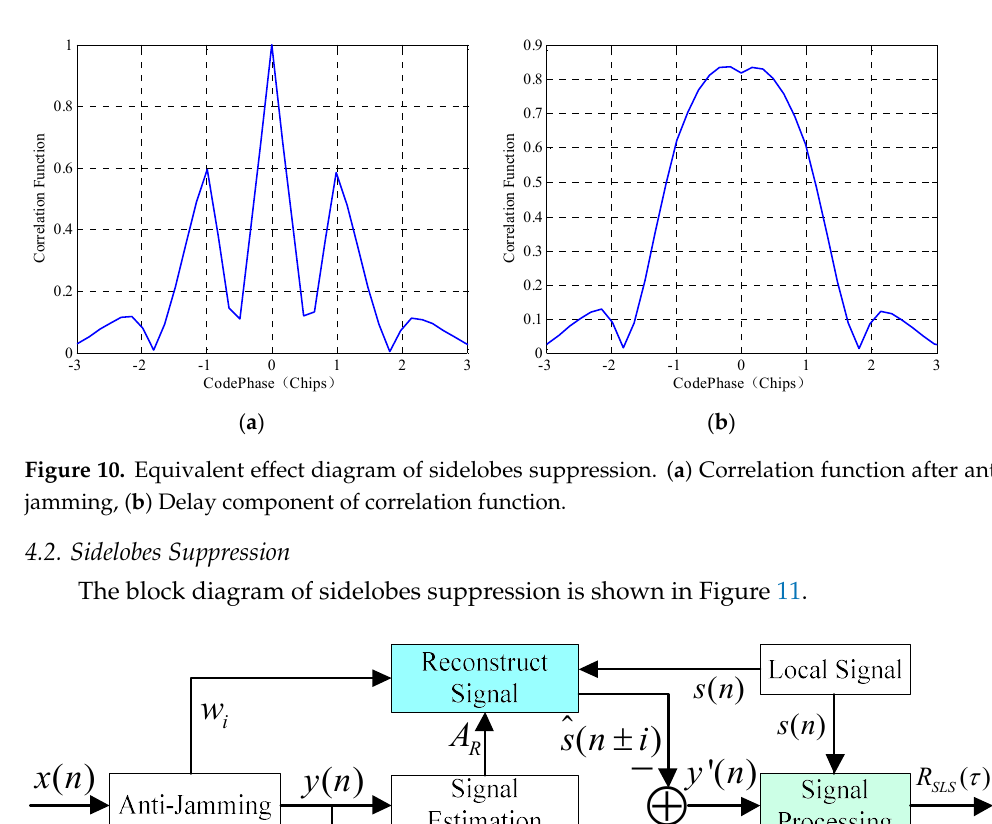
Figure 11. Block diagram of sidelobes suppression.